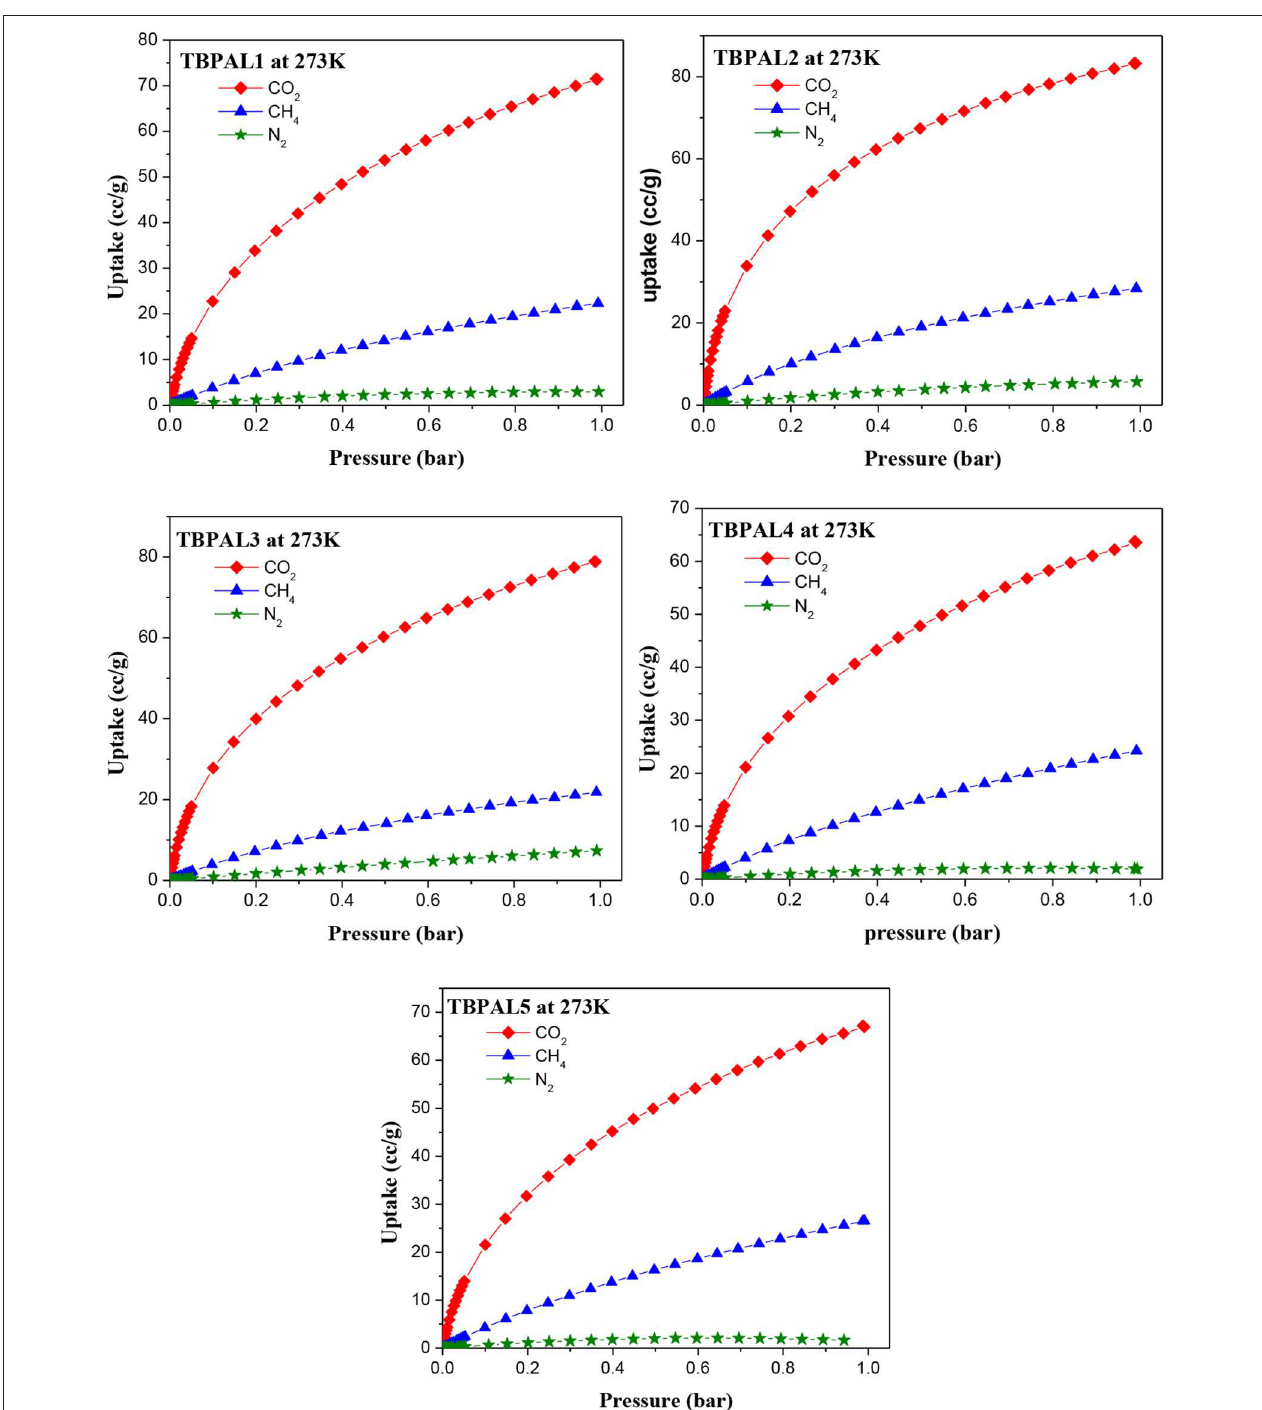
FIGURE 11 | Gas uptake capacities for TBPAL1–5 at